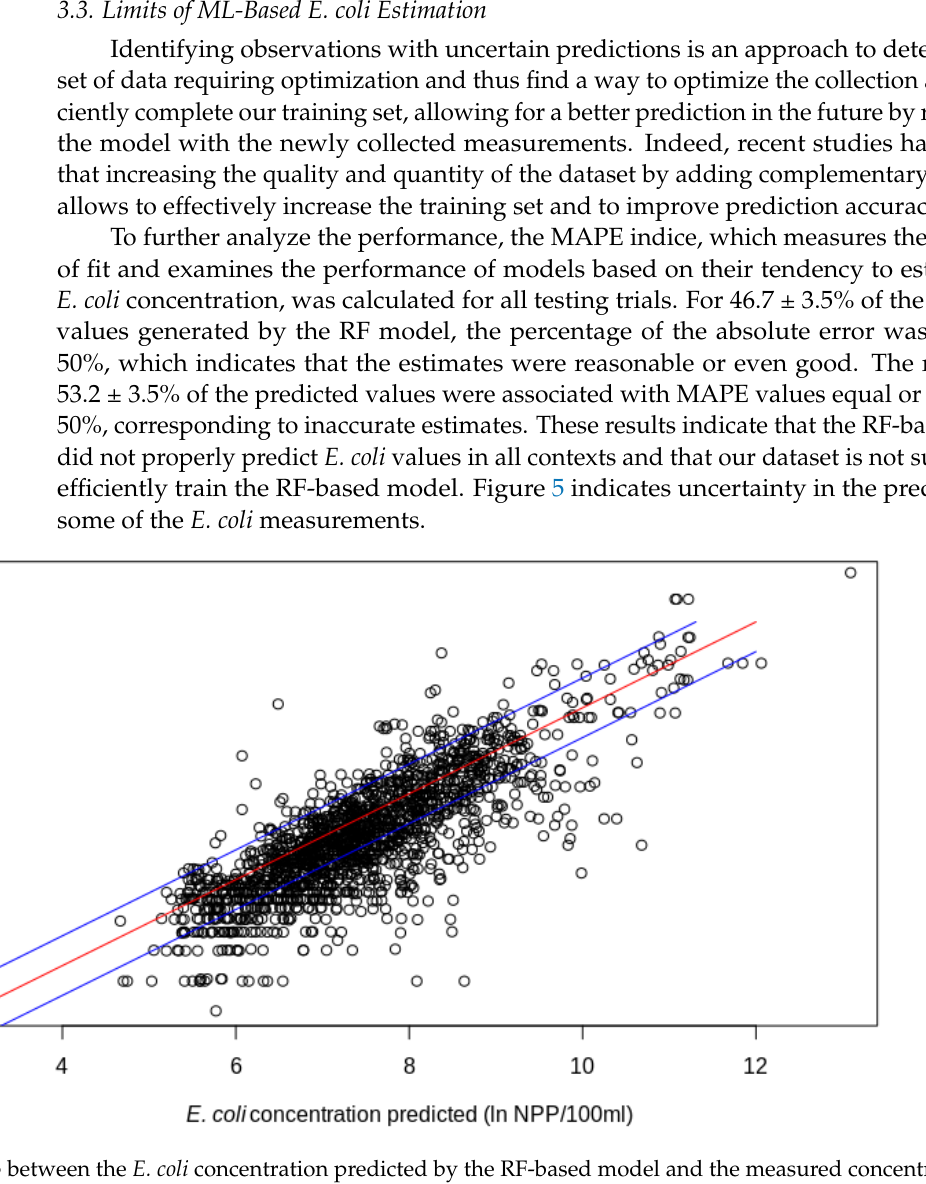
Figure 5. Relationship between the E. coli concentration predicted by the RF-based model and the measured concentration. The white circles indicate the values. The red line indicates theoretical values corresponding to an accurate prediction of the model compared to the measured values for the ten testing trials. Blue lines indicate the 50% confidence